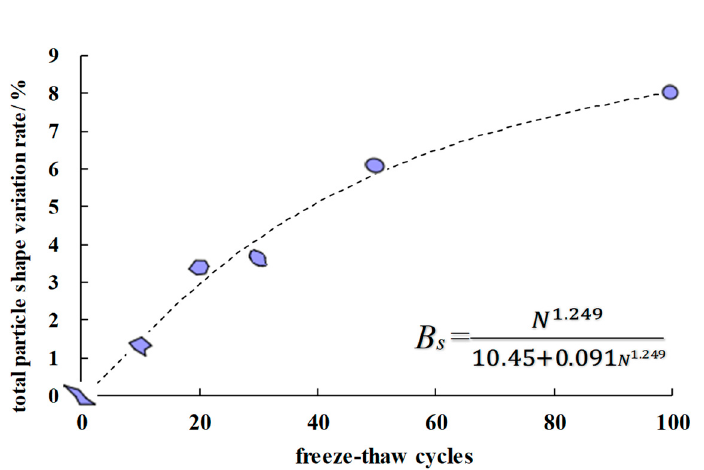
Figure 13. The effect of freeze–thaw cycles on the total particle shape of silt.